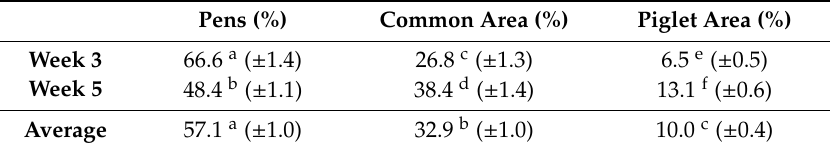
Table 2. Mean percentage and standard errors ( ± SE) of piglets at different locations within the group housing system in the 3rd and 5th week post-partum. Significant differences are indicated by different letters ( p < 0.05).